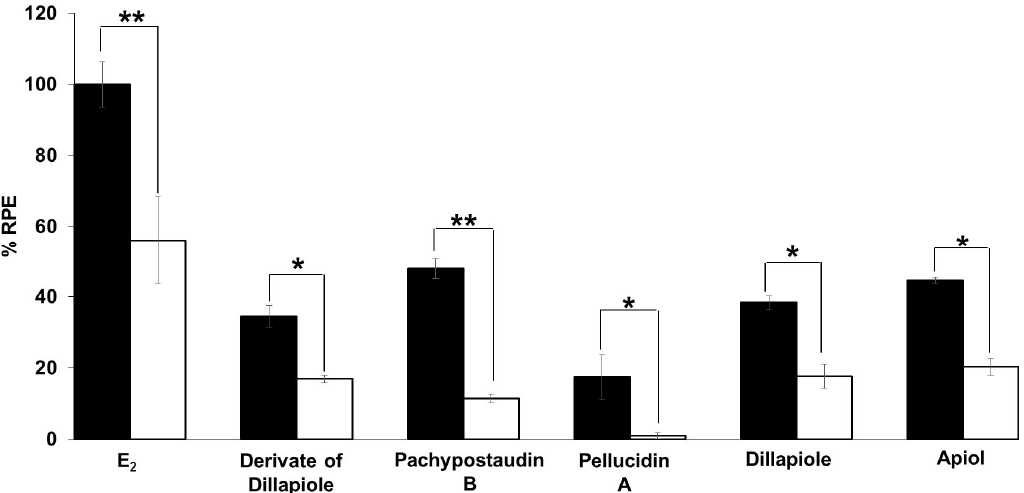
Figure 6. Estrogenic e ff ects of estradiol and the tested compounds in the presence of 10 − 6 M tamoxifen on MCF-7 / BUS cells. Cells were treated with estradiol and samples alone or in combination with tamoxifen for 144 h, and then relative proliferative e ff ects on the cells were investigated using SRB assays. The data are expressed as mean ± SD of at least two separate experiments in duplicate or triplicate for each group. Black bars indicate a testing of a single compound in isolation while white bars indicate their combination with tamoxifen. The symbols * and ** represent statistical di ff erences compared with the estrogenic e ff ect of the samples alone: * p < 0.05, ** p < 0.01, analyzed by the independent-samples t-test or Mann–Whitney U